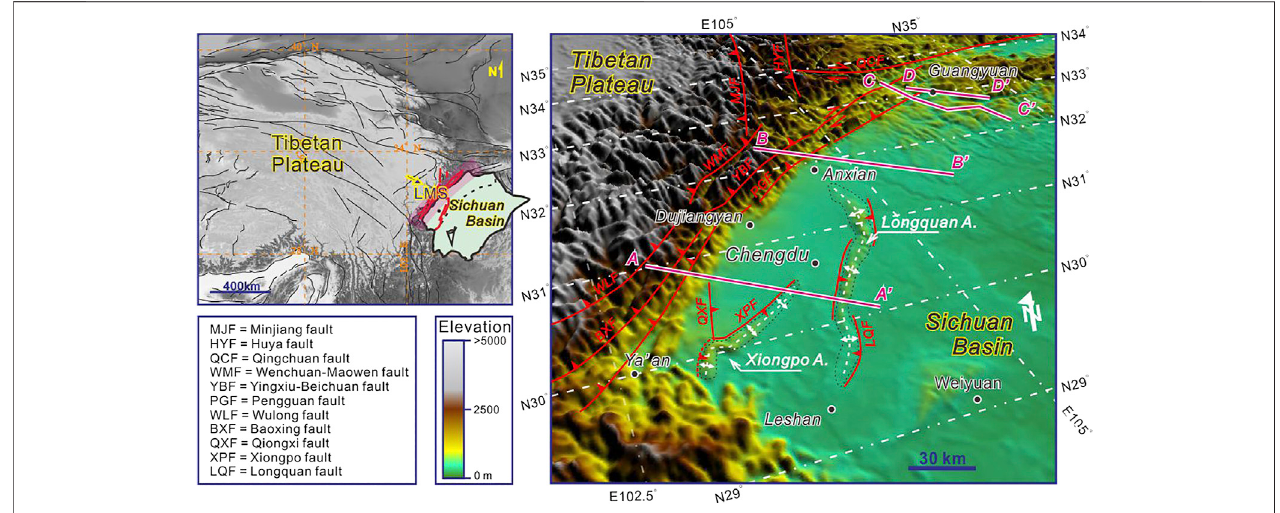
FIGURE 1 | Morphological features in the western Sichuan (an oblique view). The pink lines indicated the locations of four cross sections in Figure 2 , roughly. A. indicates anticline; LMS, Longmen Shan.